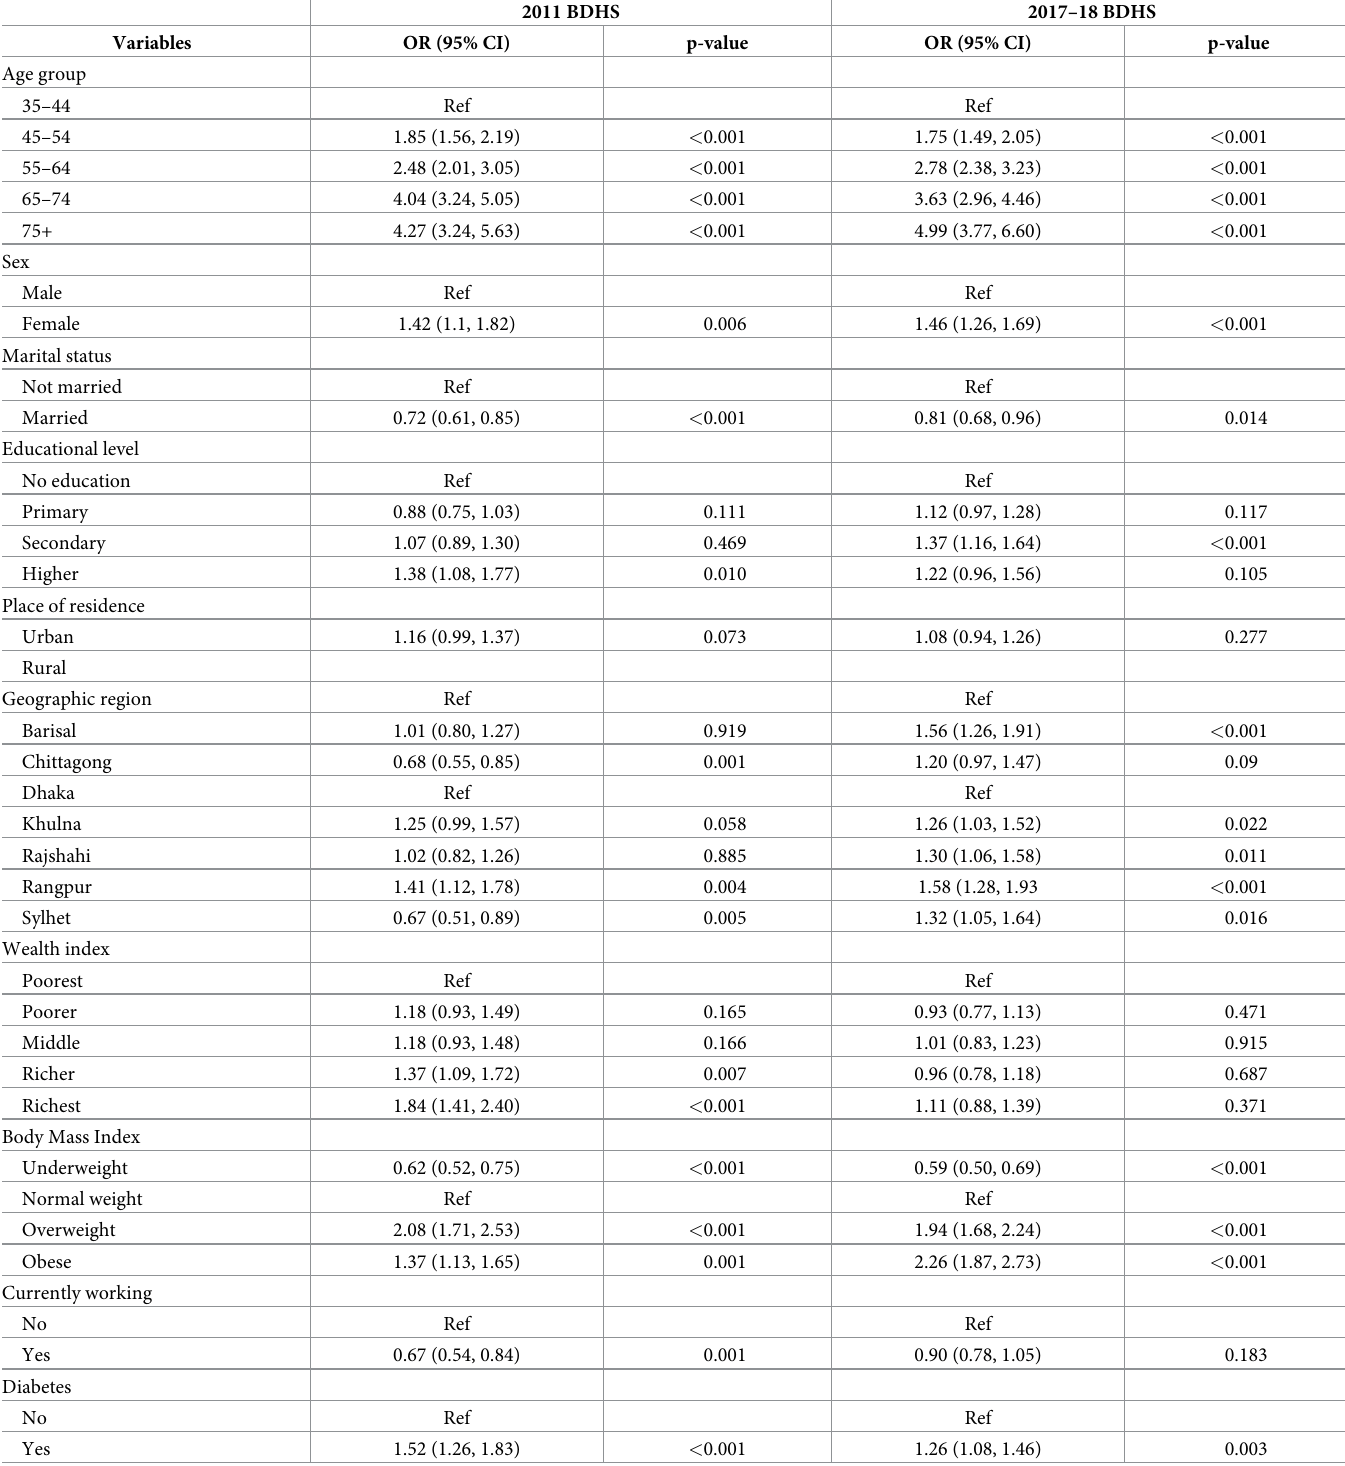
Table 2. Adjusted odds ratios of potential factors associated with hypertension among adults age 35 and older in Bangladesh, BDHS